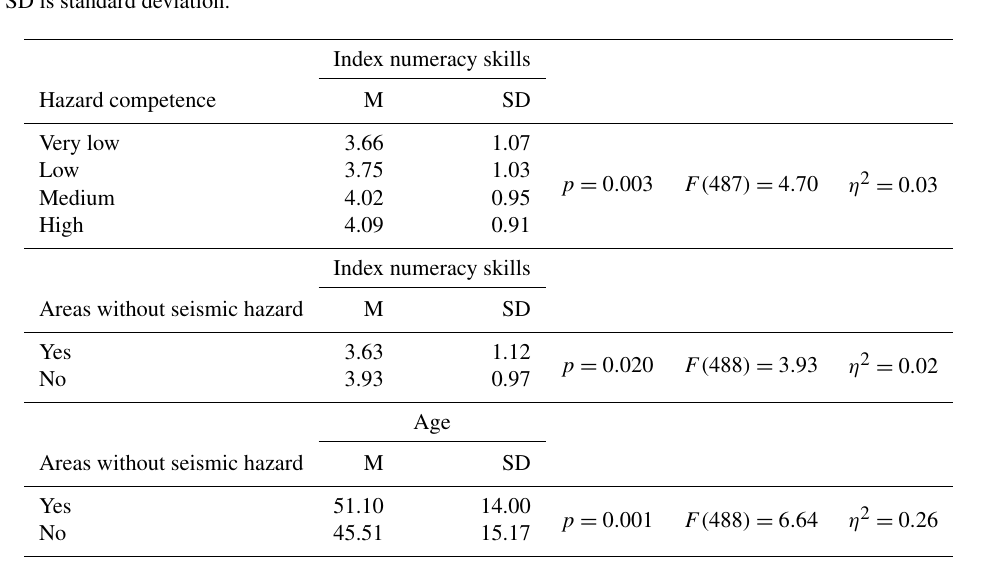
Table 6. Univariate analysis of variance with the numeracy skills index as dependent variable and hazard competence as independent variable as well as the numeracy skills index and age as dependent variables and the areas without seismic hazard as independent variable ( N = 491). M is mean, and SD is standard deviation.